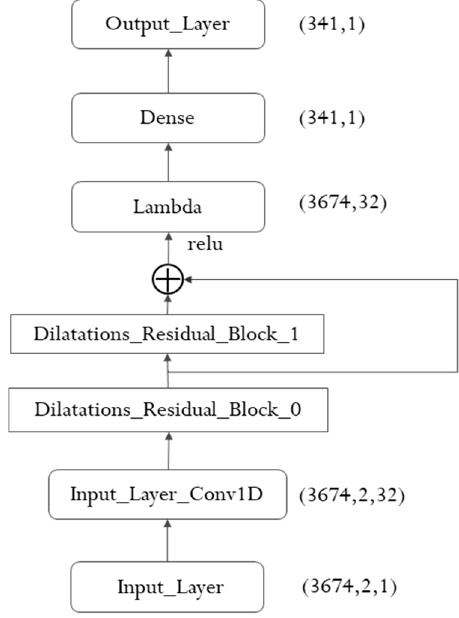
Figure 2. TCN-based architecture for wind power forecasting.